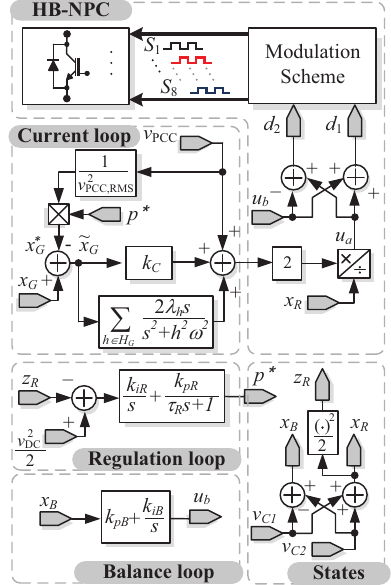
Figure 3. Block diagram of the proposed